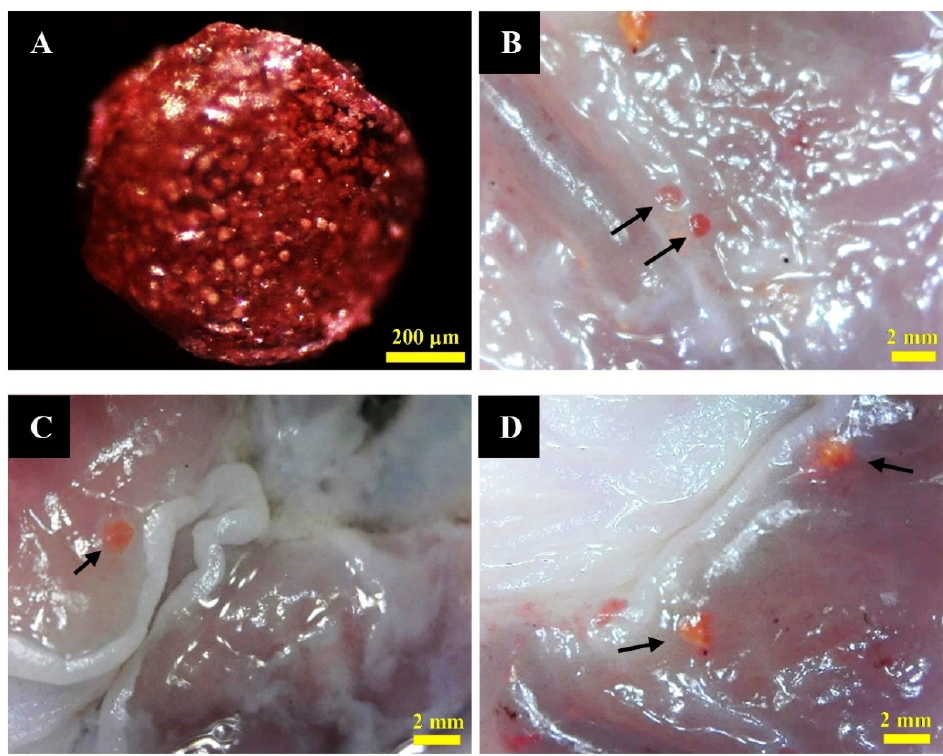
Figure 7. Mean plasma MTF concentration-time profile for pure MTF and MTF-loaded LCS-ALG beads following single oral administration equivalent to 25 mg/kg bw of MTF to STZ-induced diabetic Sprague-Dawley rats. Data shown as mean ± SE, ( n = 6). Solid lines are guides to the eye.